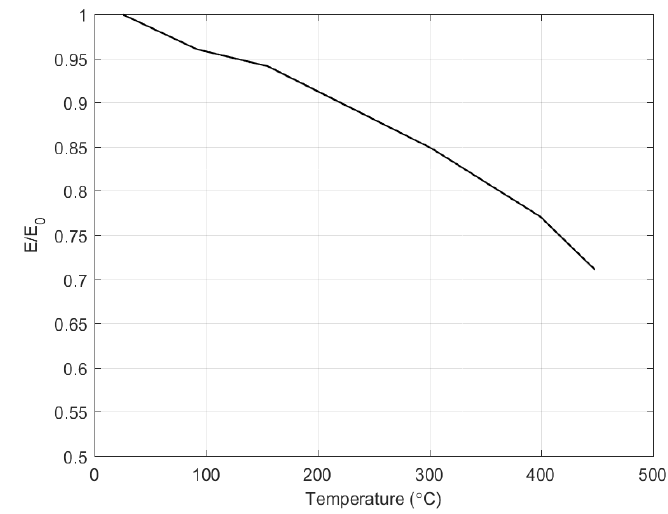
Figure 2. Variation of Aluminium 2024-T3 Young’s modulus with